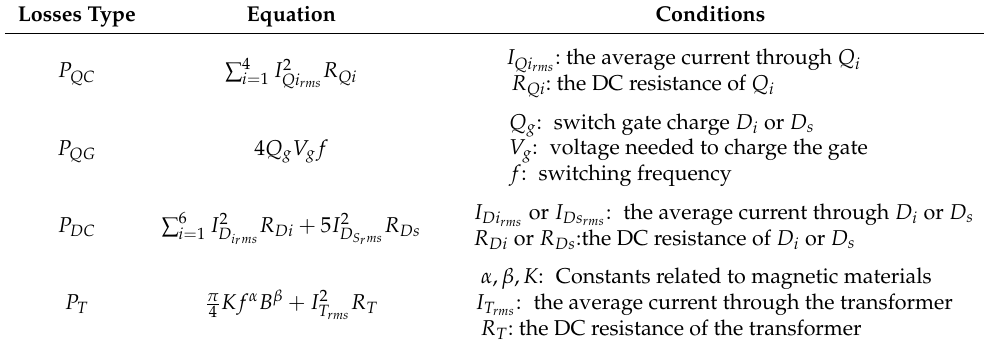
Table 1 is the main power loss of the ZVS-HBPS-LVHC-SI [31]. Table 1. The power loss of the